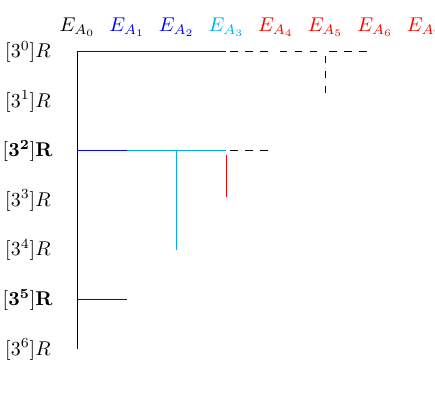
Side-channel attack. Using Lemma 2, two different outcomes of the isogeny computation can be forced depending on the value of a secret bit: the party either computes only zero values from a certain point in the tree traversal and onward, or completely random values.